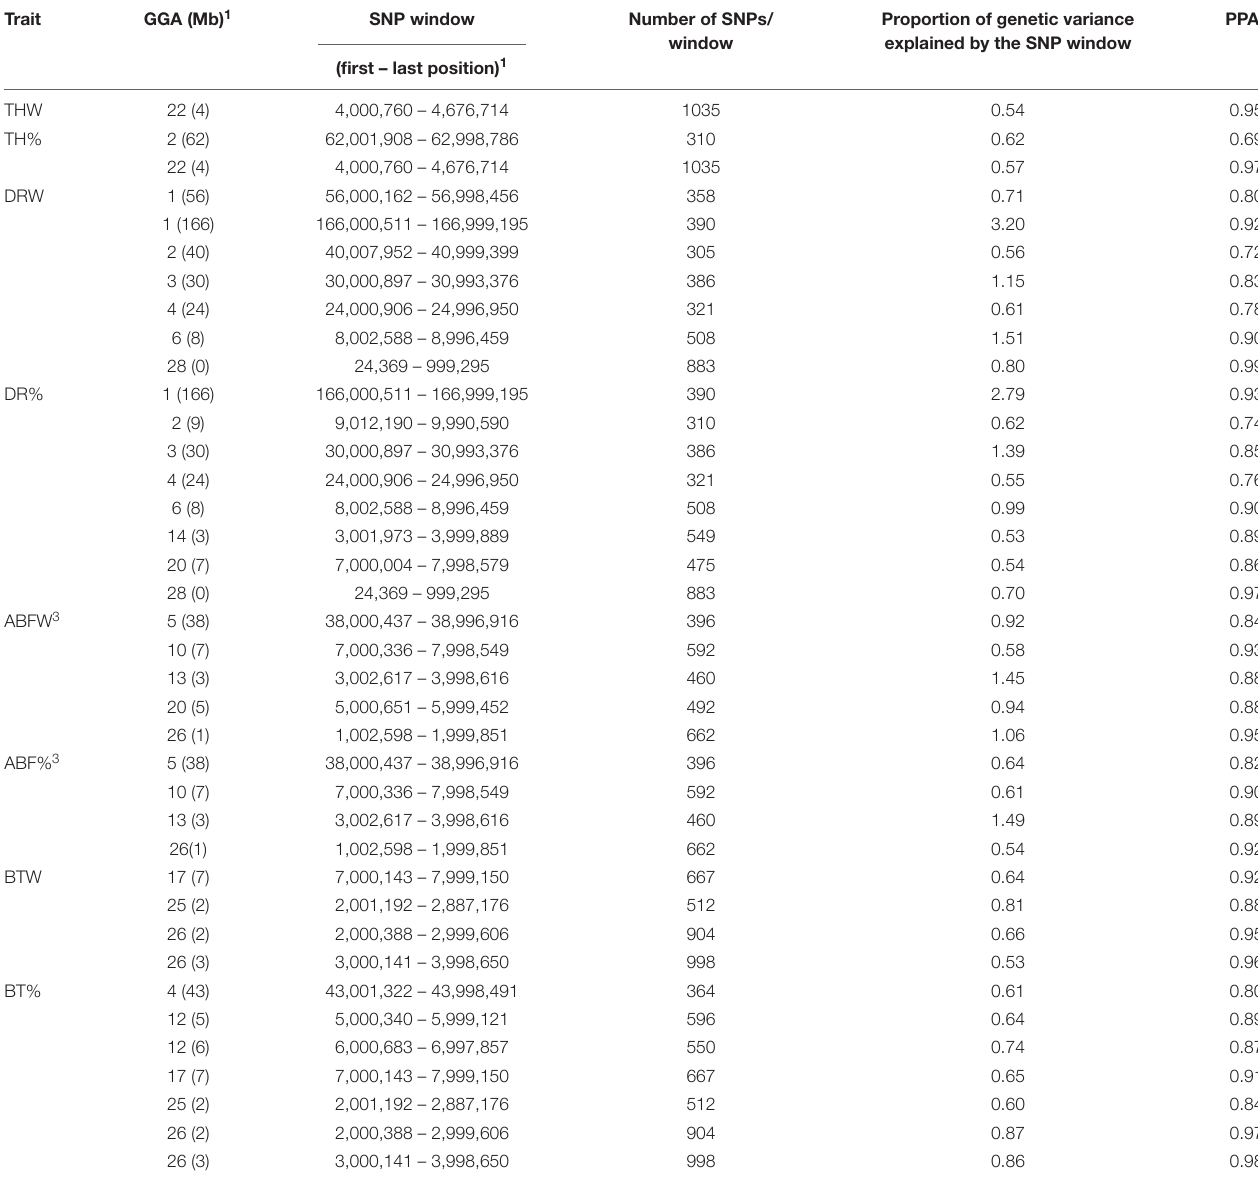
TABLE 3 | Significant genomic windows associated with THW, TH%, DRW, DR%, BTW, and BT% in the TT Reference